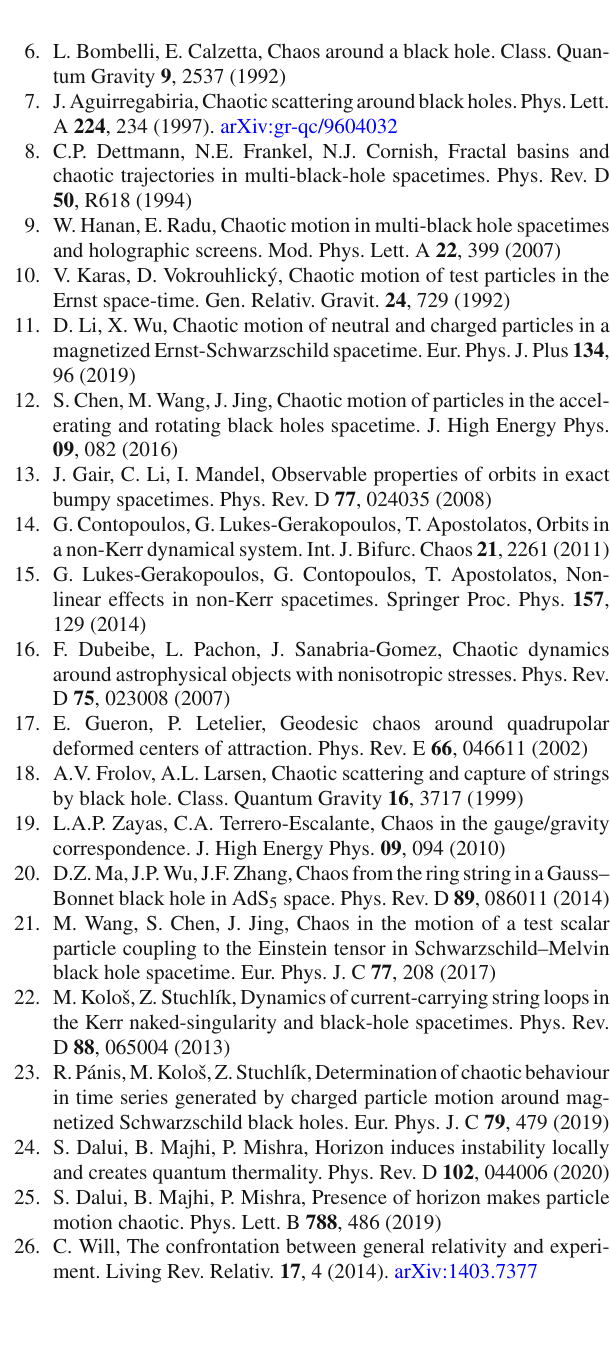
Fig. 11 The fractal basins of attraction for the coupled scalar particle in a Kerr black hole spacetime with the fixed parameters a = 0 . 8, α = 45, E = 0 . 95 and L = 2 . 4